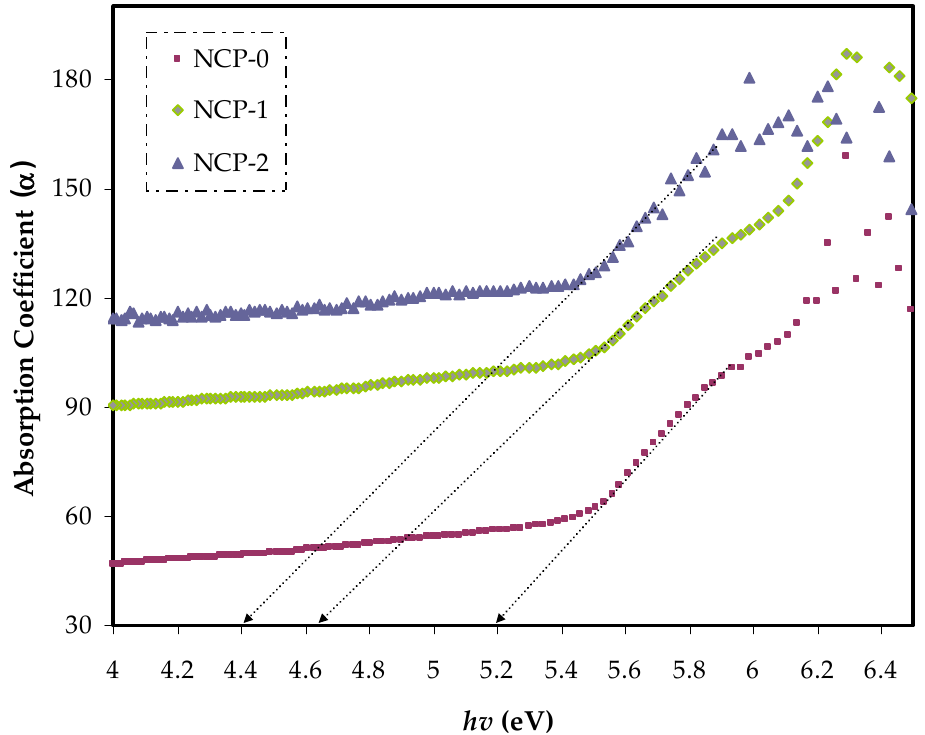
Figure 5. Absorption coefficient against photon energy for NCP-0 and composite films. Table 1. Absorption edge for NCP-0 and composite films.